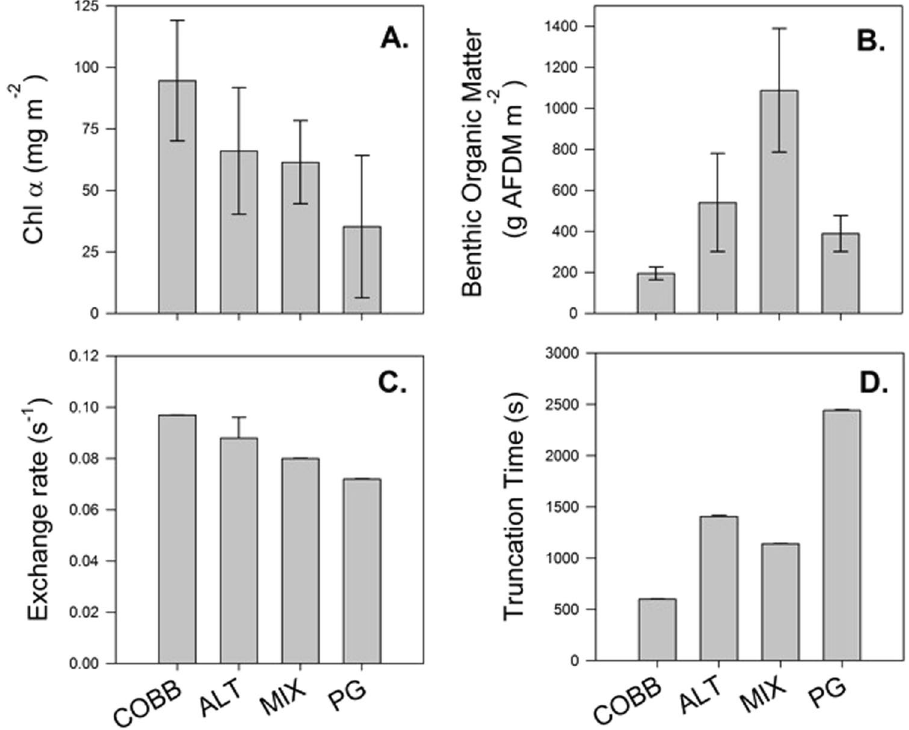
Figure 3. Quantification ( ± SE) of chlorophyll a ( A ), benthic organic matter ( B ), hyporheic exchange rate ( C ), and truncation time ( D ) for all LEEF streams. Data for panels C and D are from Aubeneau et al . 20